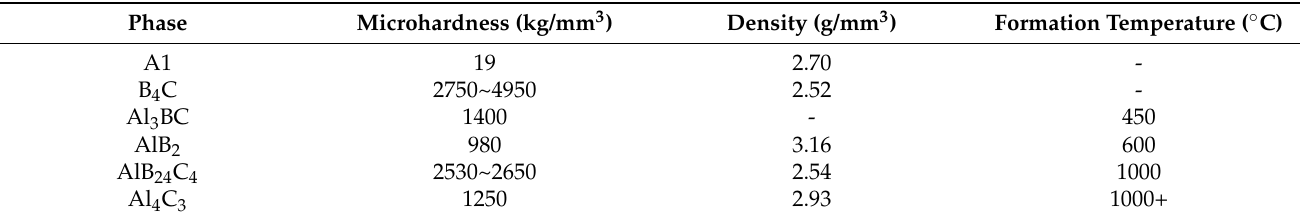
Table 4. Physical properties of each reaction product of the Al–B 4 C system